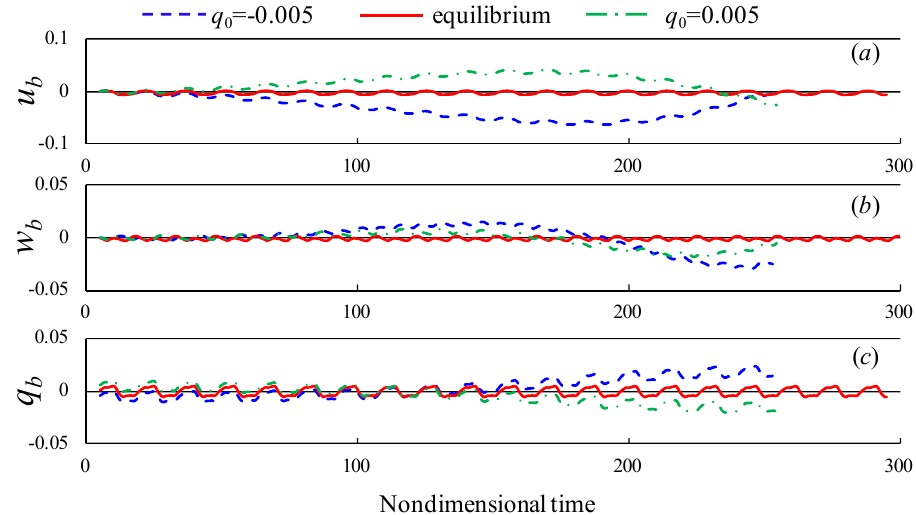
Figure 3. ( a-c ) Time variations of state variables ( u b , w b , q b ) under initial conditions of w 0 = -0.05 (dashed blue lines) and w 0 = 0.05 (dashed dotted green lines) with u 0 = v 0 = p 0 = q 0 = r 0 = 0 and t 0 = 5.17.